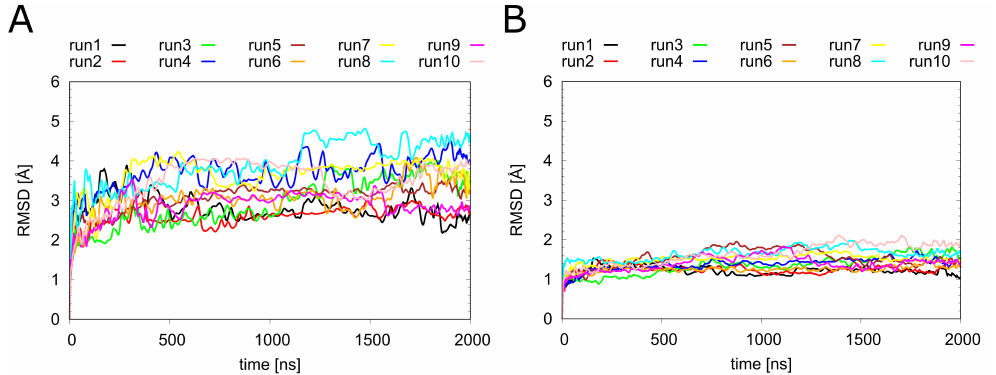
Figure 3. Dynamics of H 1 R in the presence of different ligands. Root-mean-square deviation (RMSD) calculated for ( A ) the entire backbone and ( B ) only the C α atoms of the transmembrane helices of the H 1 receptor. The individual runs denoted above the graphs correspond to the following systems: H 1 R-DS (run1, run2), H 1 R-DSP (run3, run4). H 1 R-D (run5, run6), H 1 R-P (run7, run8) and H 1 R-S (run9,